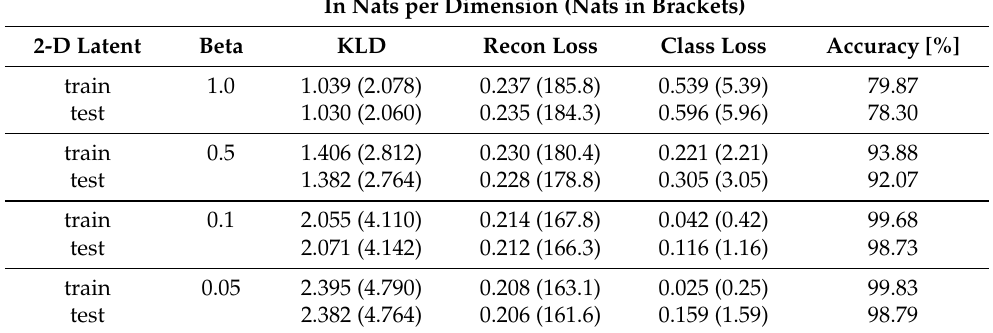
Table A1. Losses obtained for different β values for MNIST with a 2-D latent space. Training conducted in isolated fashion to quantitatively showcase the role of β . Un-normalized values in nats are reported in brackets for reference purposes.